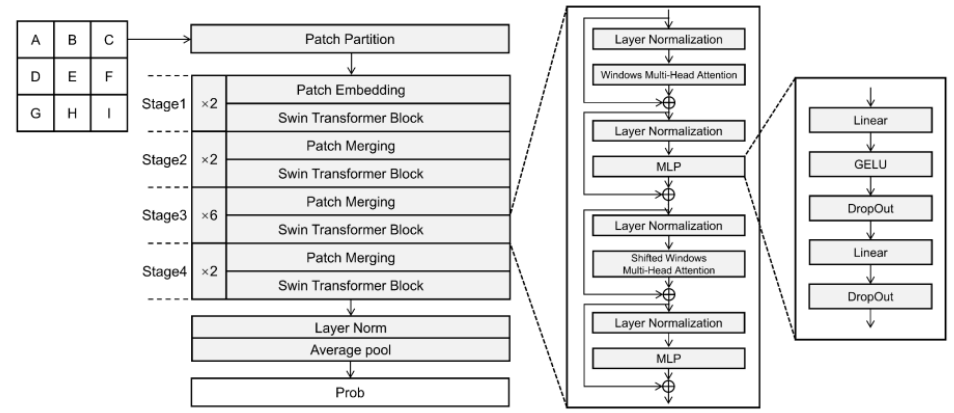
Figure 6. Swin transformer network structure.